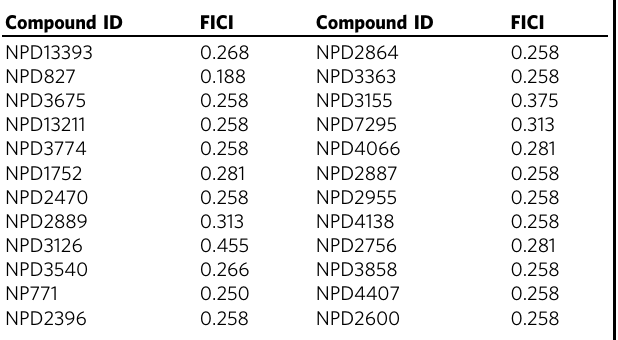
Table 1 Top 24 azole potentiators displaying a synergistic interaction with fl